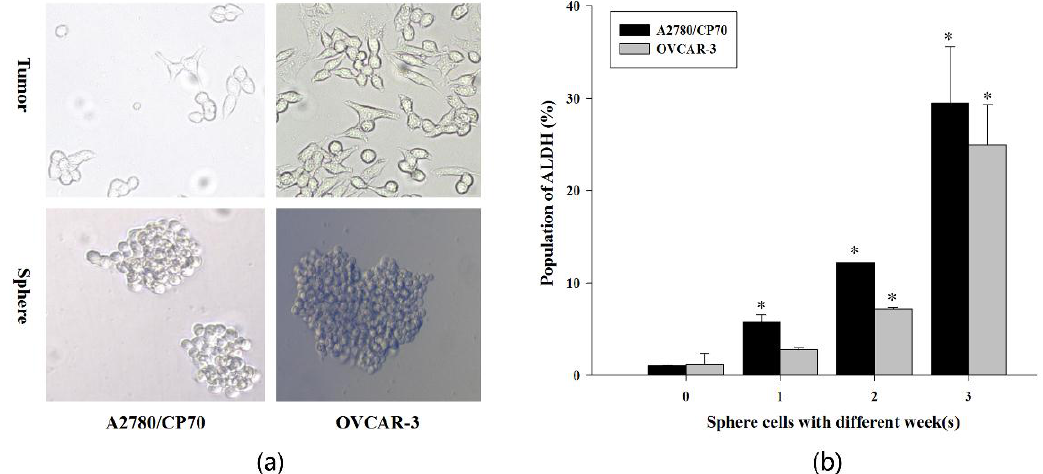
Figure 1. The population of ALDH of both tumor and sphere cells cultured in serum-free medium with different weeks from A2780/CP70 and OVCAR-3 cell lines. ( a ) morphological photographs of ovarian tumor and sphere cells (3-weeks) for both two cell lines (200 × ); ( b ) ALDH ratio after culturing in serum-free medium could accumulate in a time-dependent manner. Data was expressed as percent of ALDH+ cells and shown as mean ± SD ( n = 3), * = p ≤ 0.05, a significant difference compared with zero-time control.